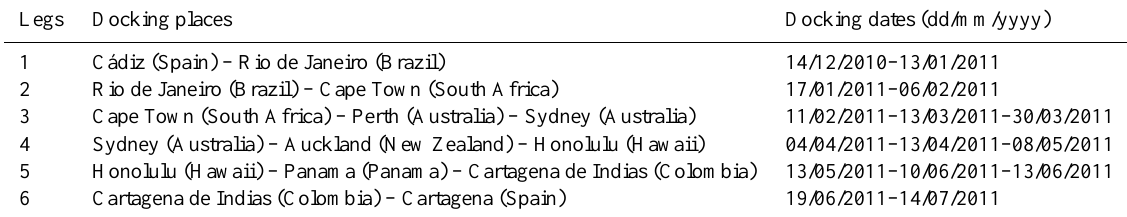
Table 1. Description of the different legs of the Malaspina 2010 expedition. Due to technical problems, the O 3 and IO measurements presented in this work correspond to the period from 21 February 2011 to 12 July 2011. Legs Docking